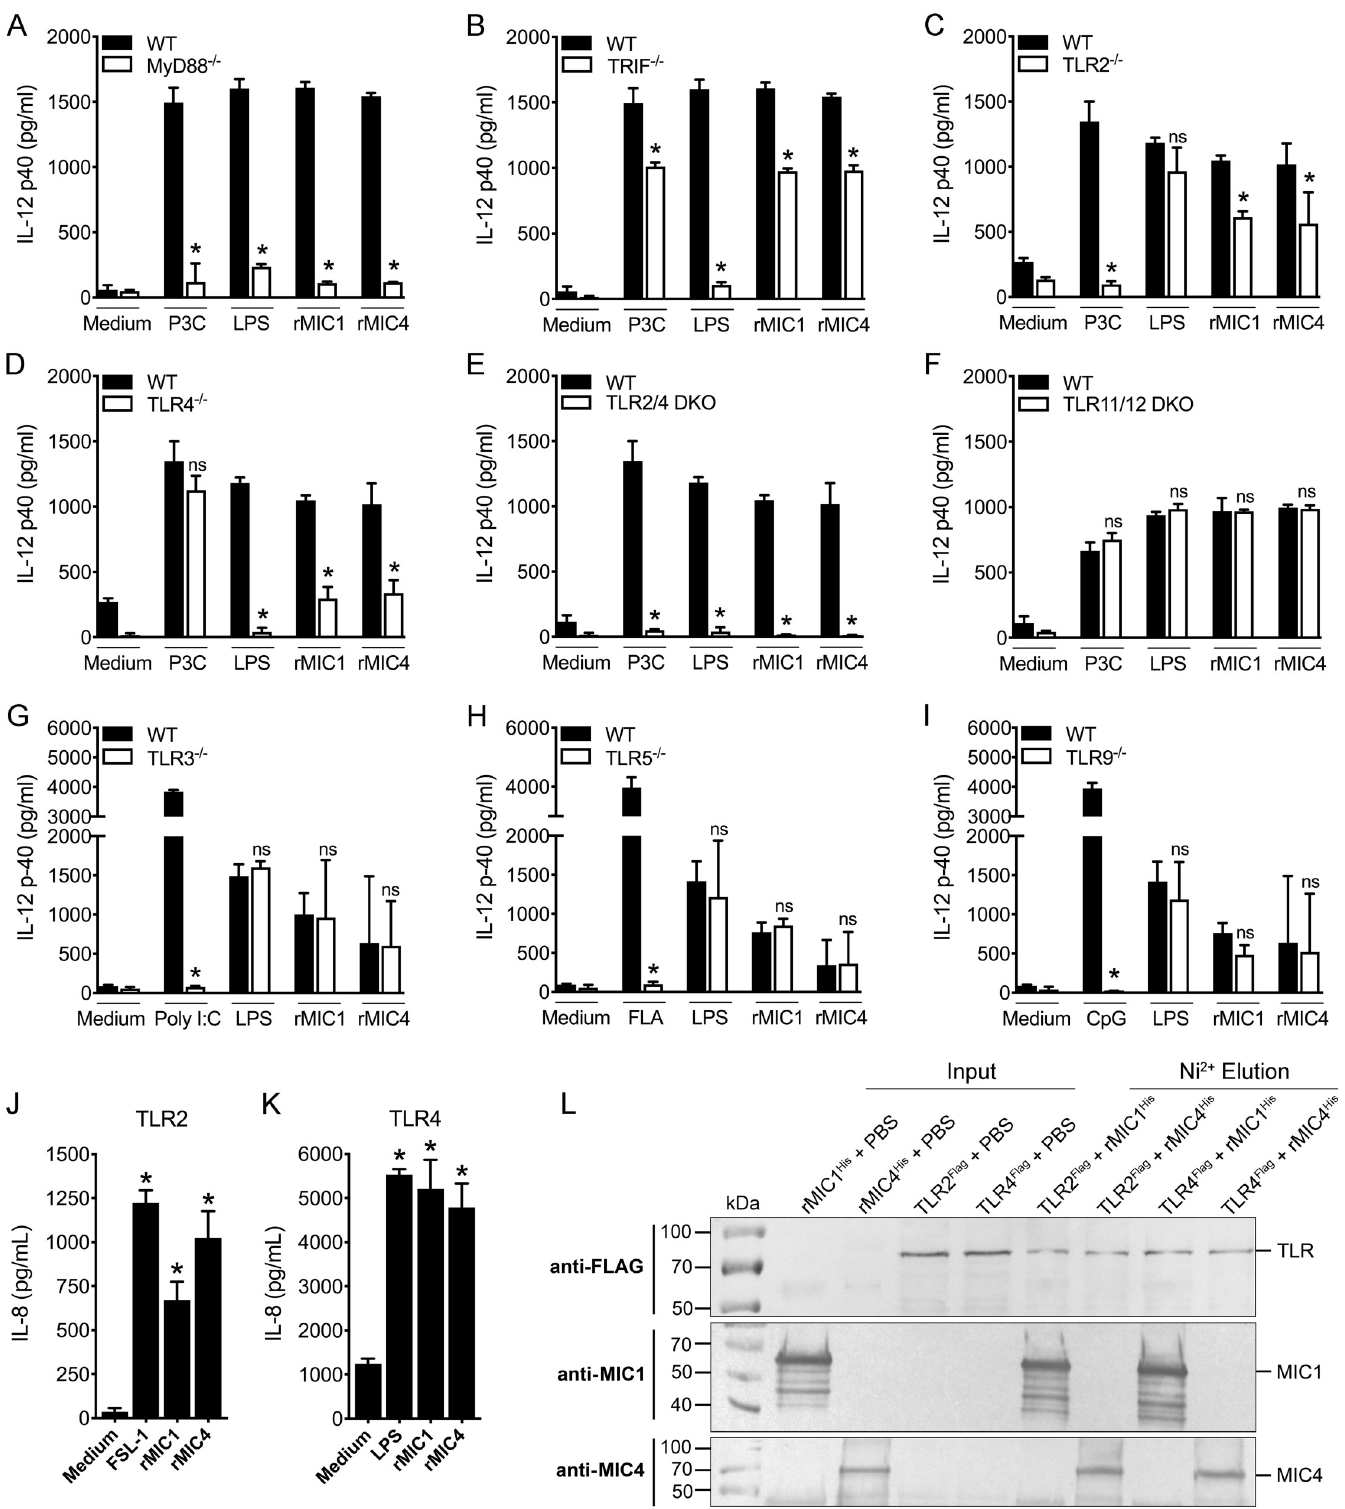
Fig 3. The IL-12 production induced by rMICs is dependent on binding to TLR2 and TLR4. (A-I) Bone marrow-derived macrophages from WT, TLR2 -/- , TLR4 -/- , double knockout TLR2 -/- /TLR4 -/- , TLR3 -/- , TLR5 -/- , TLR9 -/- , and double knockout TLR11 -/- /TLR12 -/- mice, all of the C57BL/6 background, were stimulated with rMIC1 or rMIC4 (5 μ g/mL) for 48 h. Pam3CSK4 (P3C) (1 μ g/mL), LPS (100 ng/mL), Poly I:C (10 μ g/mL), Flagellin (FLA) (1 μ g/mL) and CpG (25 μ g/mL) were used as positive